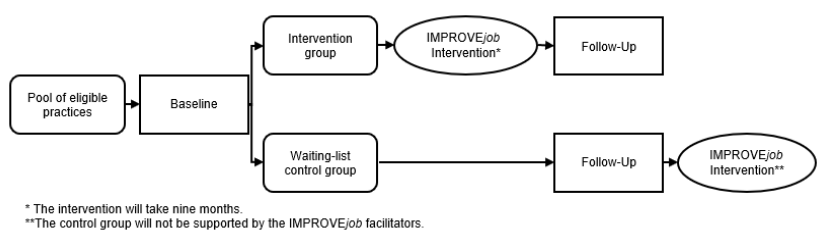
Figure 1. Study design, reprinted from